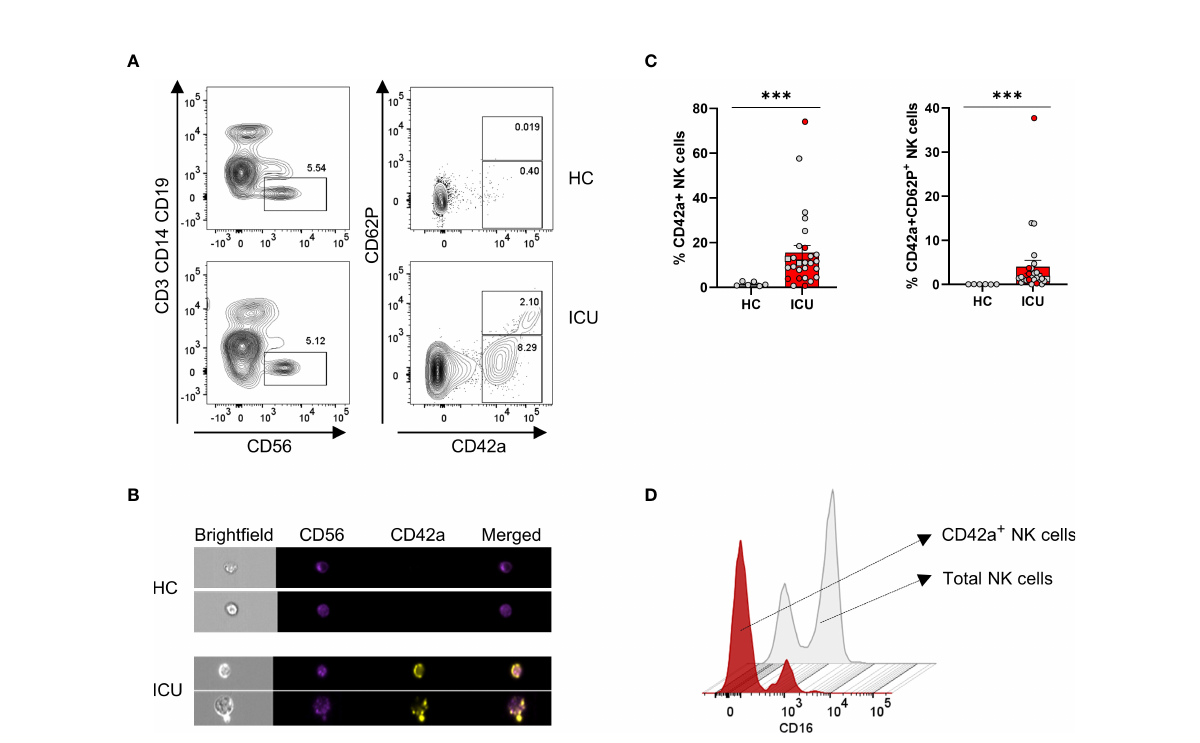
FIGURE 7 ICU patients present with platelet-NK cell aggregates in which platelets are largely activated. (A) Contour representation of platelet-NK cell aggregates with NK cells gated as CD3-CD14-CD19-CD56+ and platelets gated as CD42a+. Activated platelets are de fi ned as CD42a+CD62P+. The top line depicts a representative healthy control (HCs), and the bottom line, a representative ICU COVID-19 patient. (B) Imaging fl ow cytometric visualisation of platelet-NK cell aggregates in two representative HCs and ICU COVID-19 patients. CD56 is visualised in red, CD42a in yellow, and a merged image in orange. (C) Percentage expression of CD42a+ and CD42a+CD62P+ NK cells in HCs (grey bar) (n = 6) and ICU COVID-19 patients (red bar) (n = 27). Each symbol represents a single patient. Coloured symbols were obtained from fresh samples. Mann- Whitney U test was used to determine the signi fi cance between HCs and ICU. (D) Mean fl uorescence intensity (MFI) plot of CD16 on total NK cells in grey and platelet-NK cell aggregates in red. P-values were obtained using Wilcoxon signed-rank test with Bonferroni correction.